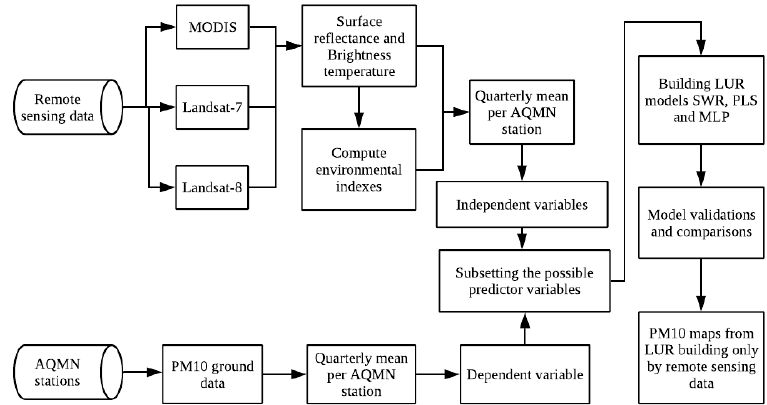
Figure 2. Workflow of the methodology proposed to establish the land use regression (LUR)